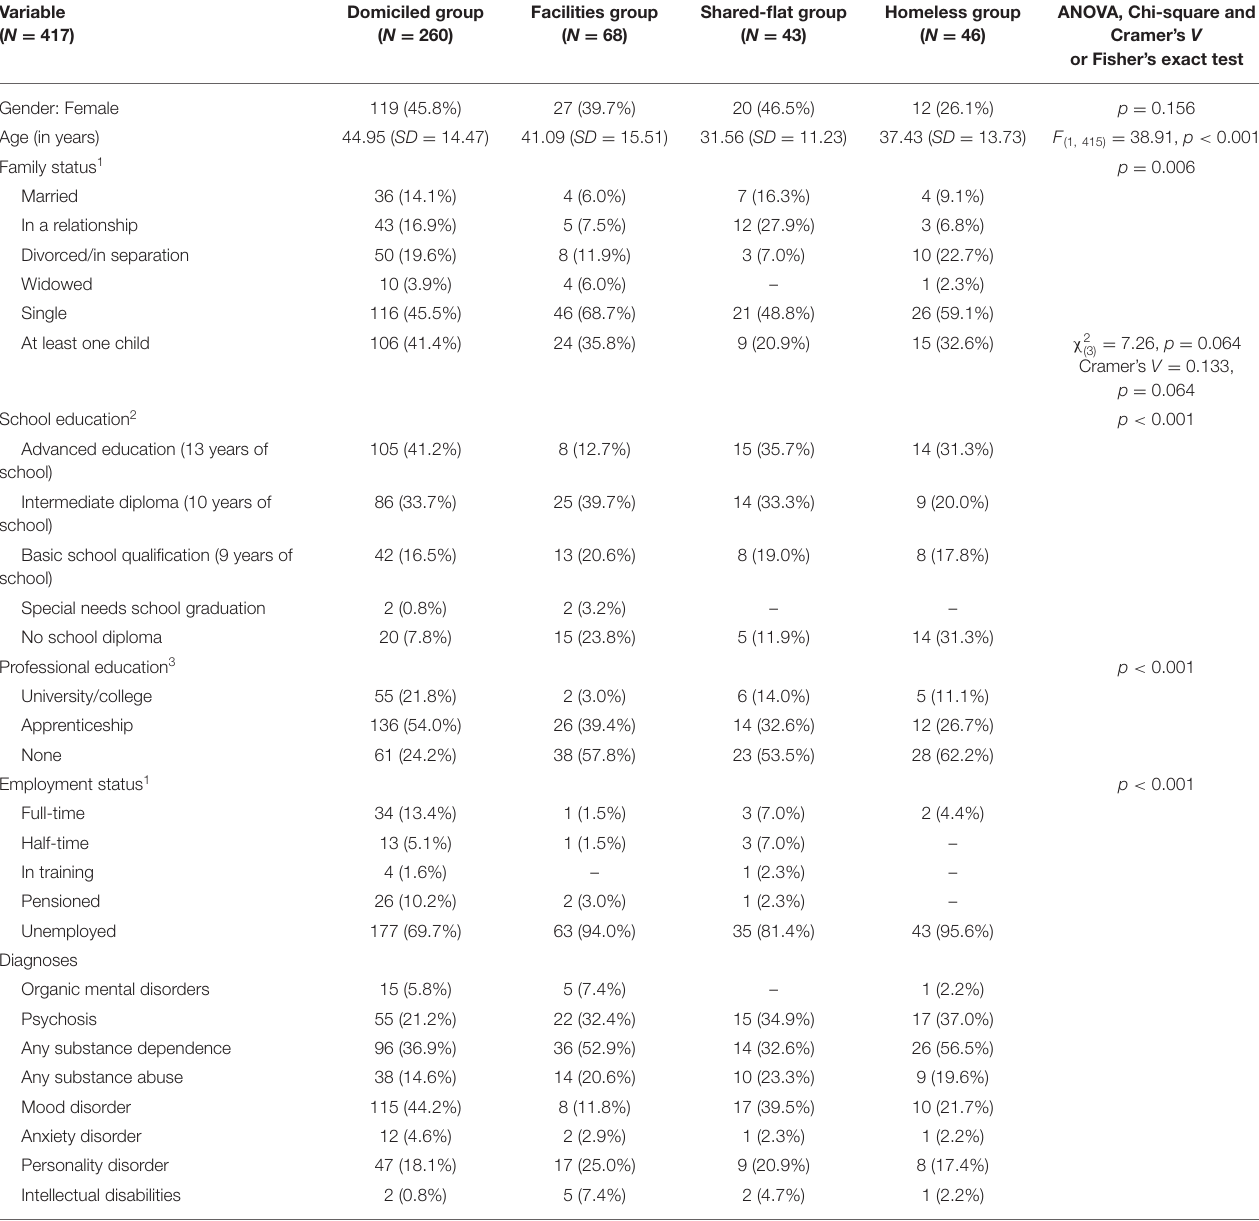
TABLE 1 | Group distributions and corresponding test results of socio-demographic variables. Variable ( N =